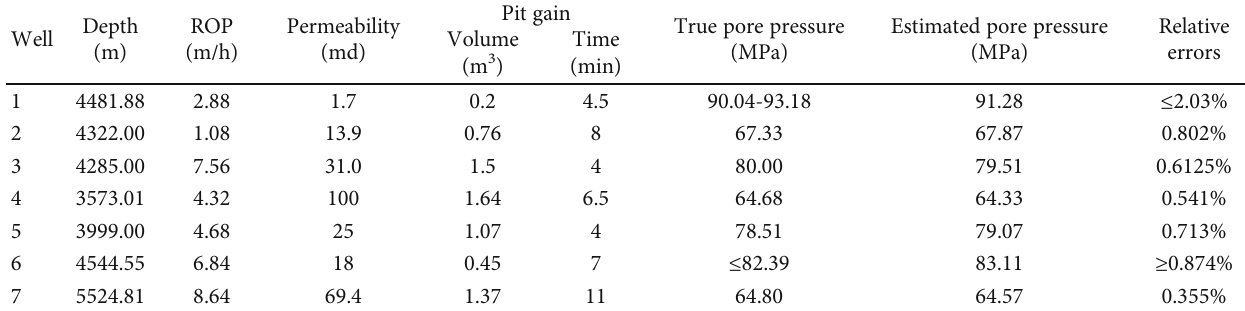
Table 2: The inversion results of seven drilled gas-kick